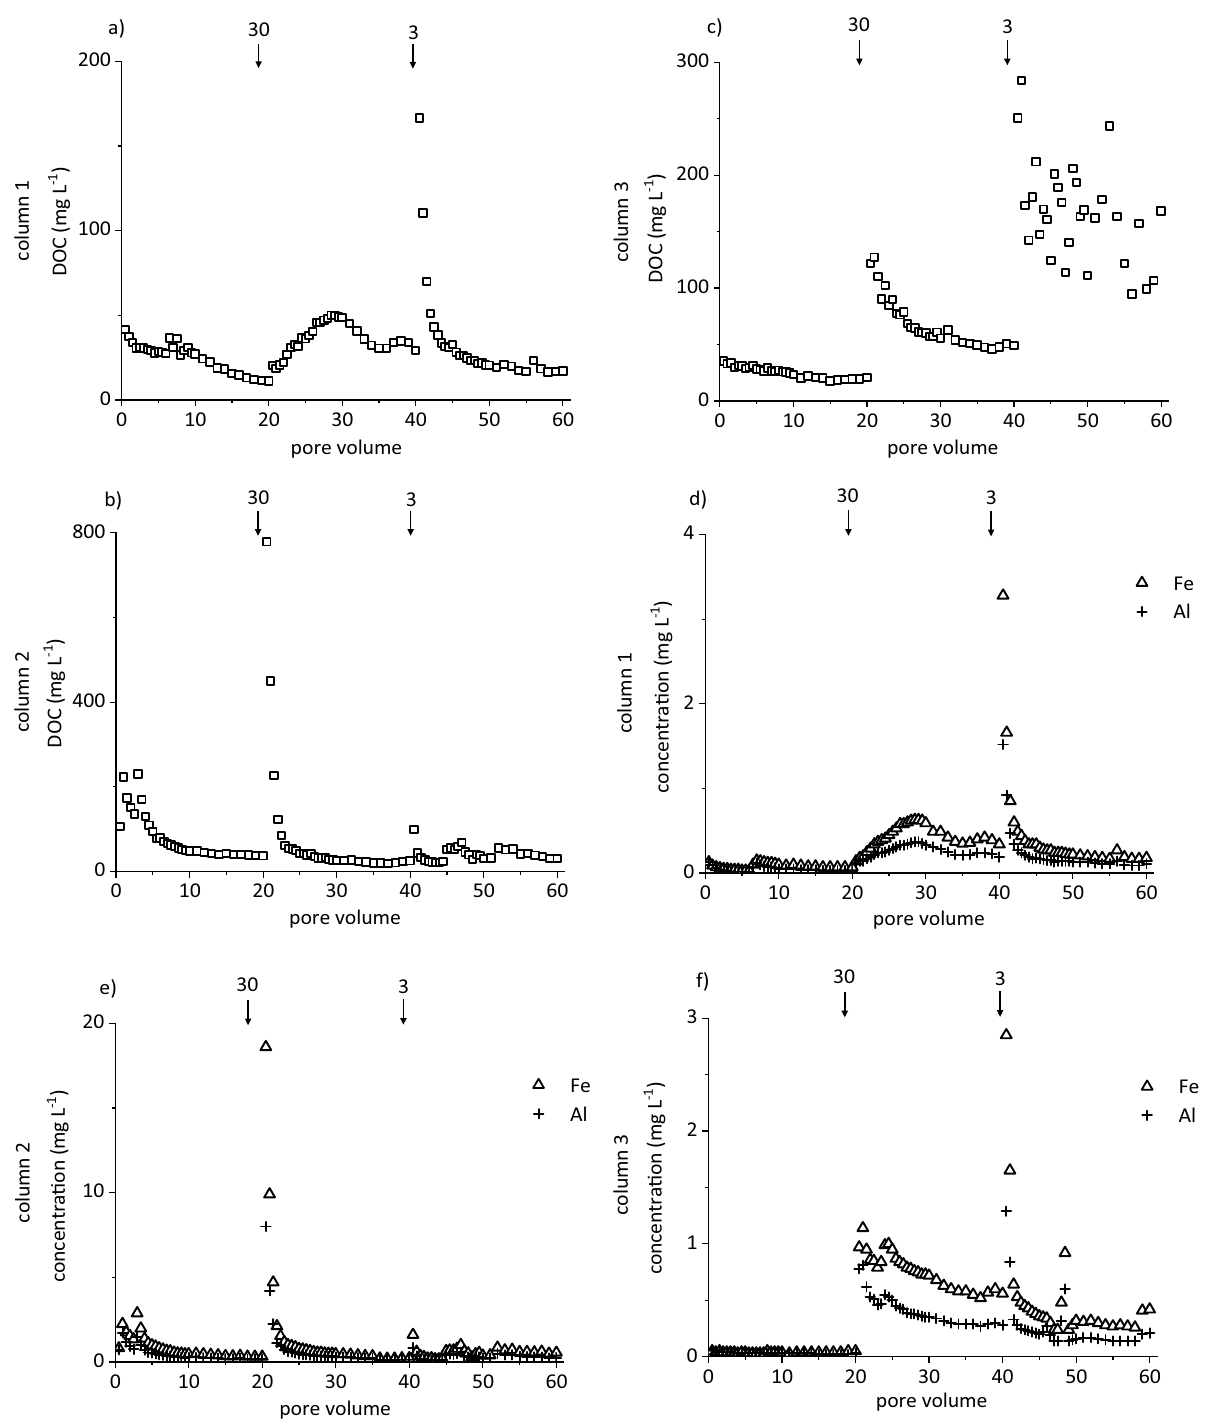
Figure 2. Concentrations of ( a – c ) dissolved organic carbon (DOC) and ( d – f ) Fe and Al in eluates from release experiments run at q = 10 mm h −1 with three soil cylinders taken from the AE horizon of a Dystric Arenosol. Arrows indicate flow interruptions and their duration in